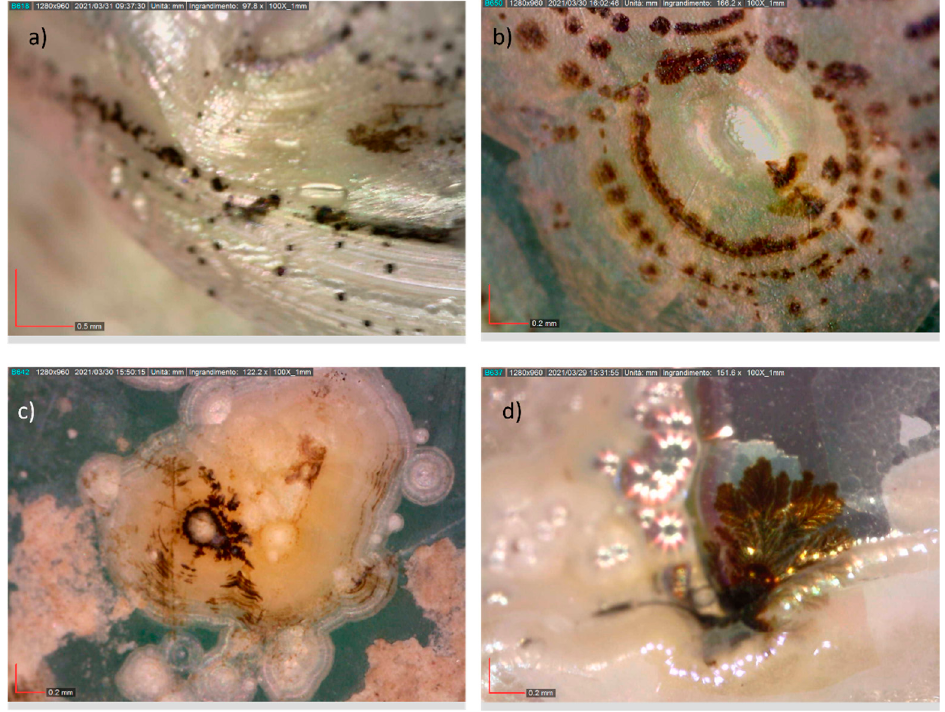
Figure 6. Dark growths in the shape of small leaves detected on fragments, documented under OM ( a ) KK_h3; ( b ) KK_b2; ( c ) KK_d4; ( d ) KK_d7. Among the assemblage of finds from Kafir Kala, ring-shaped pits were found on green-coloured glass fragments KK_b5, KK_d9, KK_d12 and KK_d14. Upon preliminary visual inspection, the surface of the fragments shows a dark, metallic shade (Figure 7a); images acquired by OM highlight the presence of dark-coloured stains (Figure 7b), which can be found over the entire extension of the surface alteration layer. The observation morphological and micro-textural features of blackening alteration. BSE images show that of pits was observed, with circular conformations and having a diameter between 5 and 20 µ m (Figure 7d). As demonstrated by EDS spot analysis, the higher electron backscatter shown by these concentric pits is due to an increase in the manganese content, up to 9.30 wt% (Figure